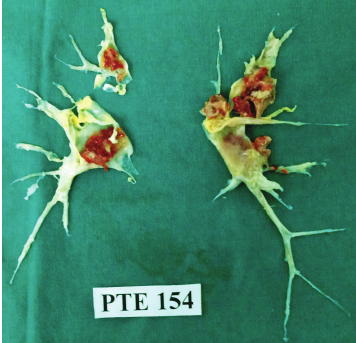
Figure 2: Photograph shows the specimen from our patient’s pulmonary